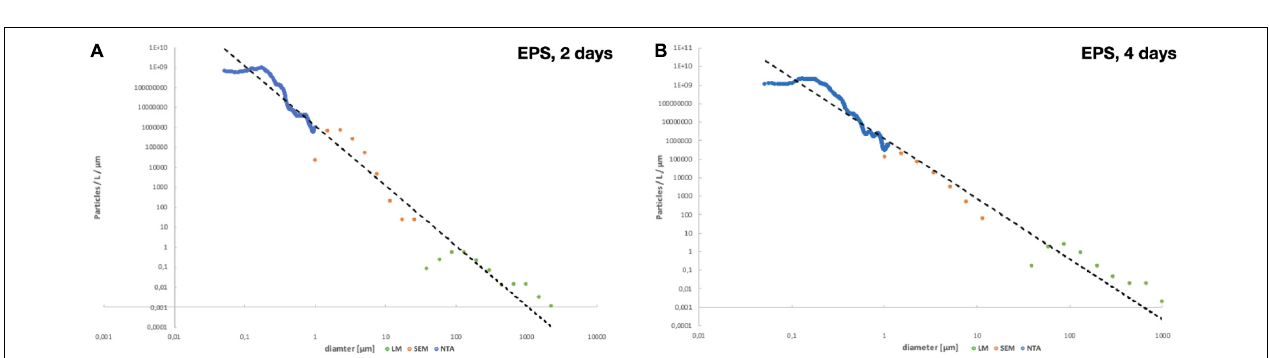
FIGURE 7 | Total size distribution per particles/L/ µ m after (A) 2 days of fragmentation and (B) 4 days of fragmentation.